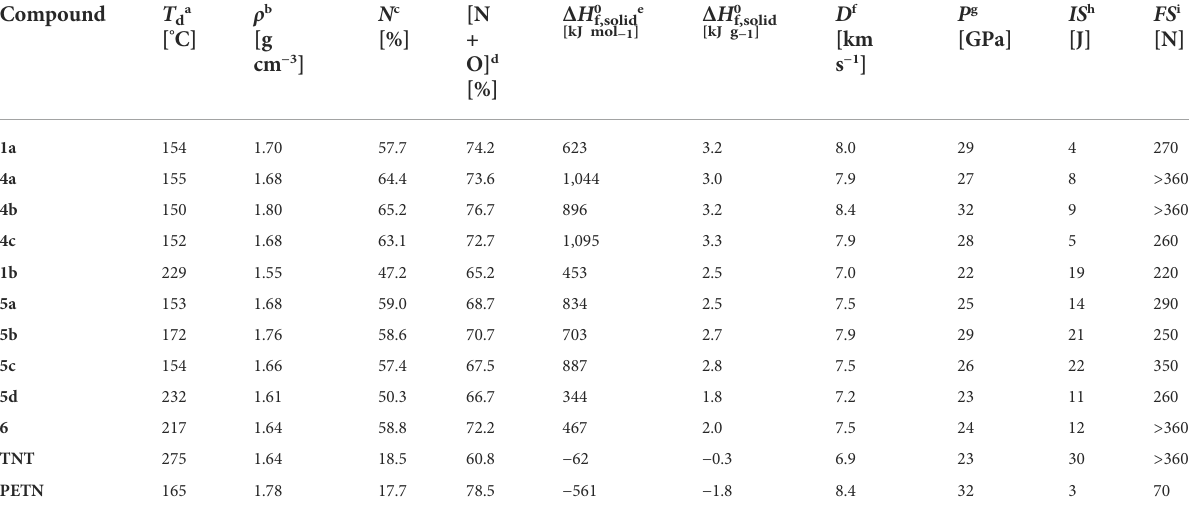
TABLE 1 Physical properties and detonation